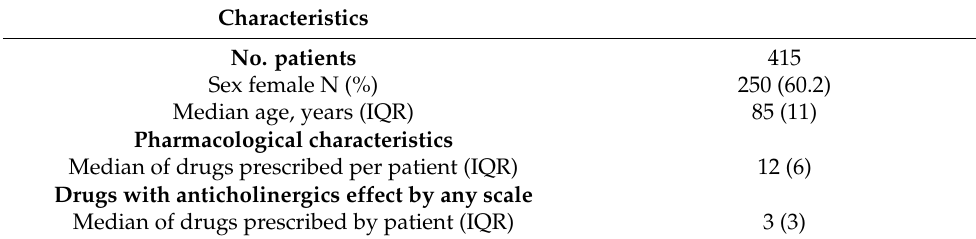
Table 1. Demographic and pharmacological